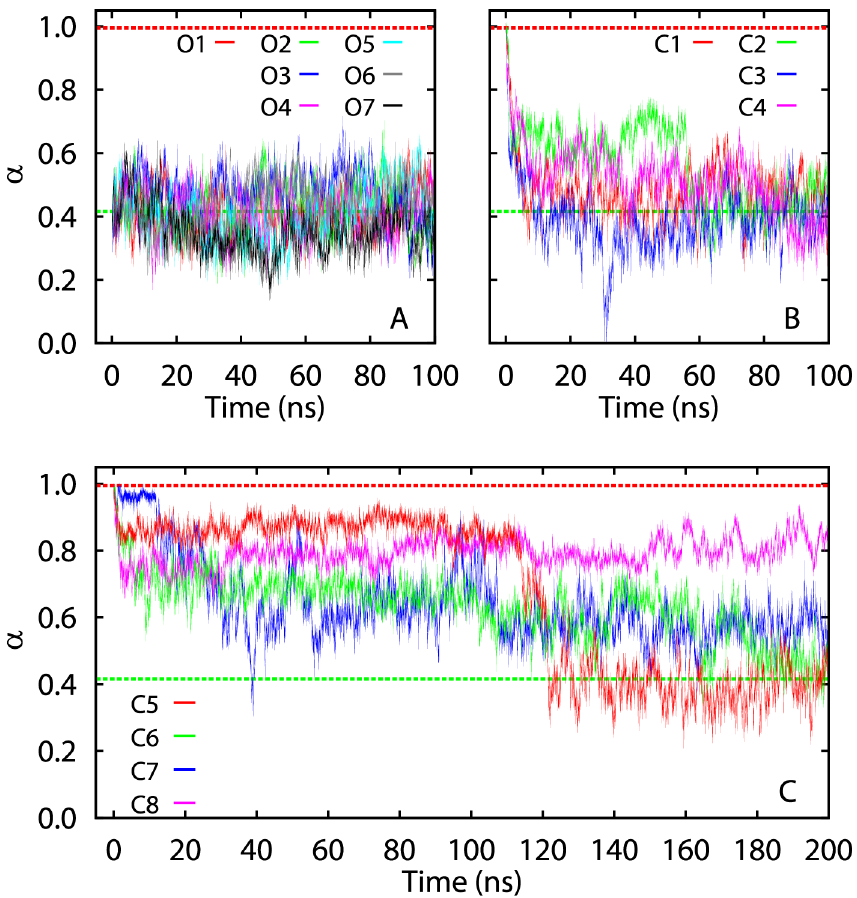
! j in the simulation trajectories was projected onto this curve through the ! a j (cid:9) (cid:10) on the curve with the shortest distance